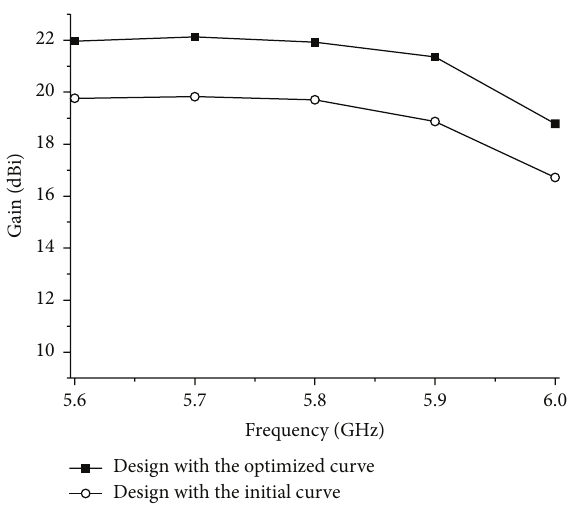
Design with the optimized curve